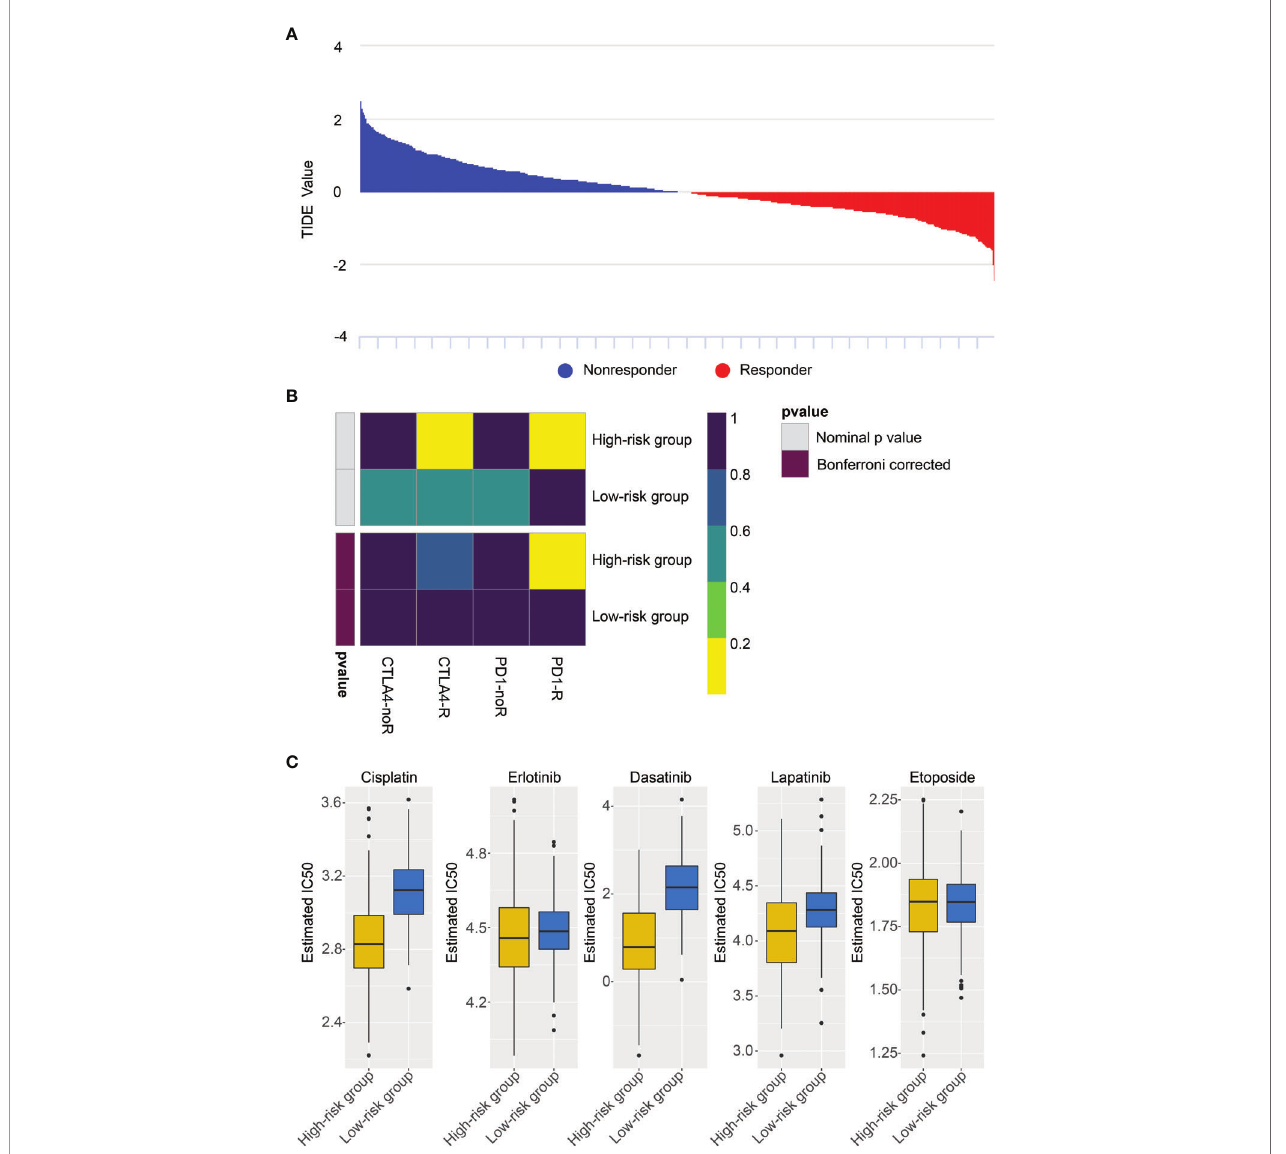
FIGURE 7 | Differential putative chemo/immunotherapeutic response. (A) TIDE value and response results to immunotherapy of patients with glioma. (B) Submap analysis showed that high-risk group may be more sensitive to anti-CTLA-4 and anti-PD-1 therapy. (C) Estimated IC50 indicates the ef fi ciency of chemotherapy to the two risk groups by Cisplatin, Erlotinib, Dasatinib, Lapatinib,